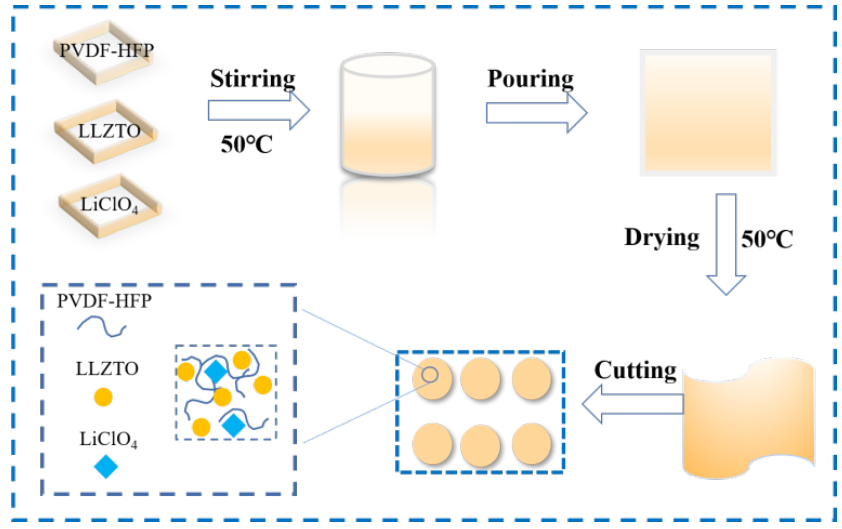
Figure 1. Schematic pattern of the preparation process of CSE.